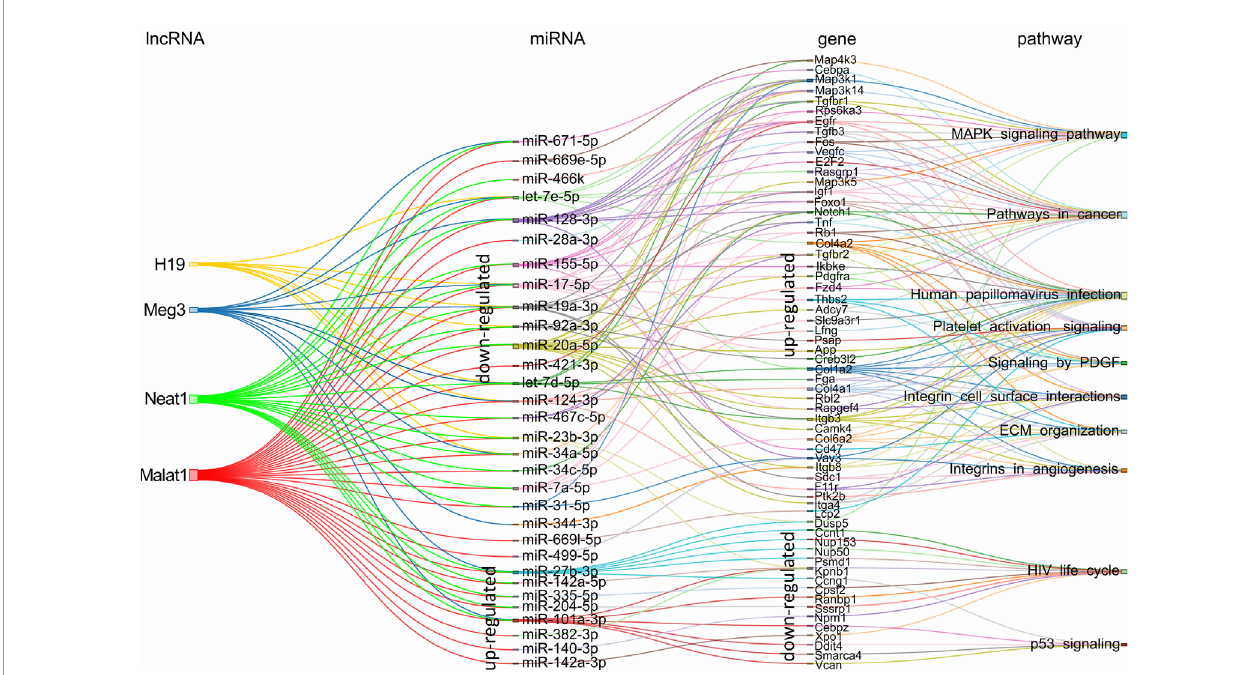
FIGURE 7 | Schematic representation of the experimentally supported triad lncRNA-miRNA-mRNA and the pathways in which the later are involved for the KSHV- dependent in vitro to in vivo transition. The expression status in KSHV (+) tumors is indicated for miRNAs and their respective